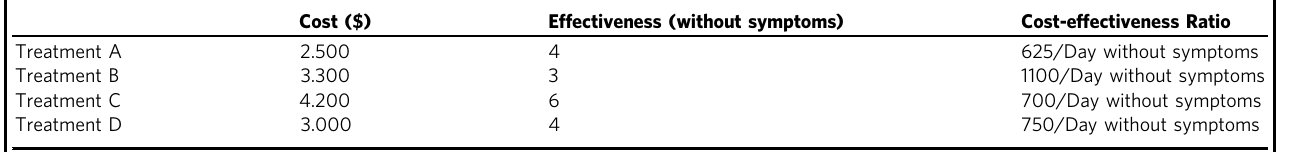
Source: adapted from